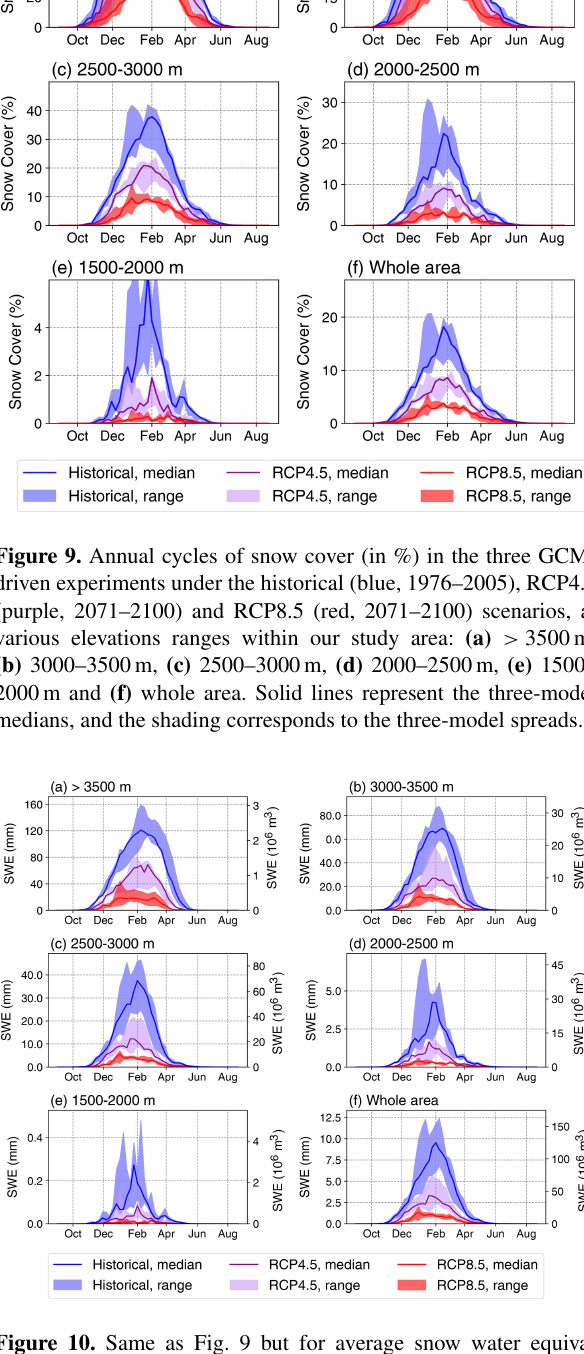
Figure 10. Same as Fig. 9 but for average snow water equiva- lent (mm, left-hand axis) and corresponding total snow water con- tent (10 6 m 3